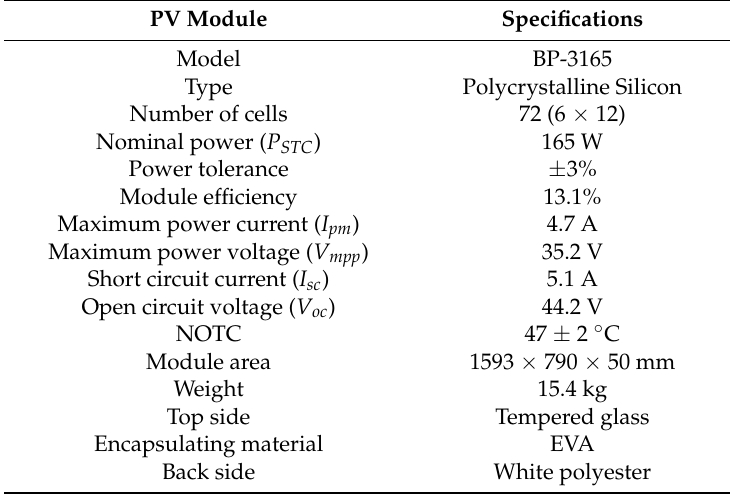
Table 2. PV module technical specifications.